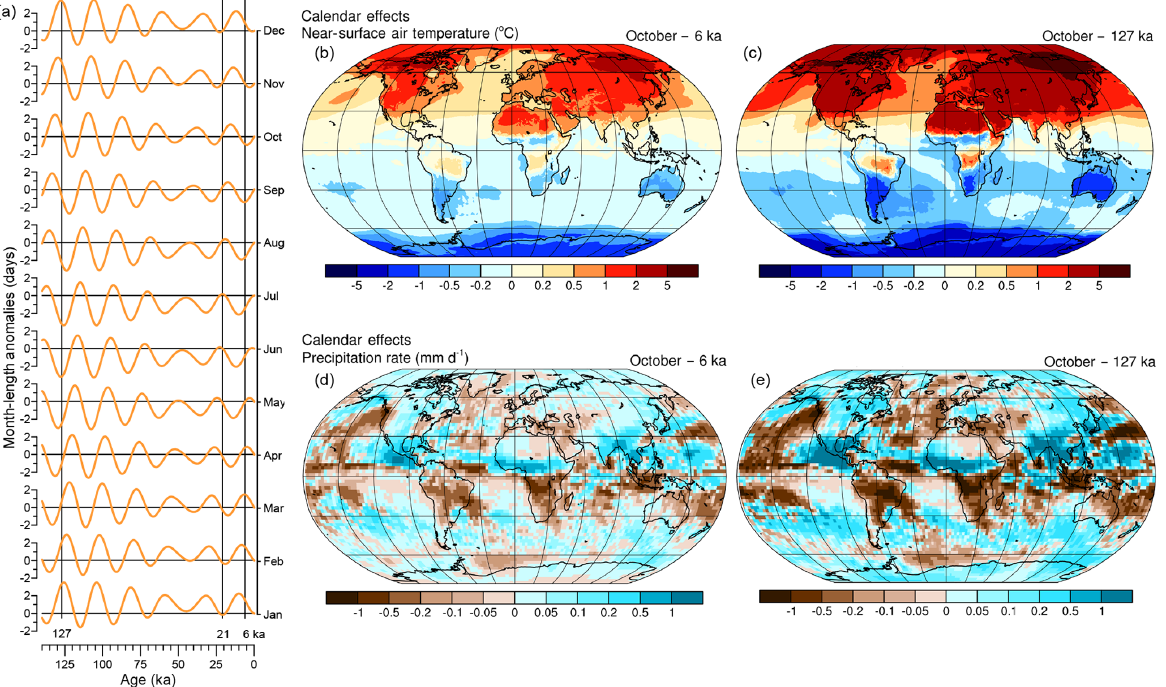
Figure A1. The calendar effect: (a) month-length anomalies, 140ka to present, with the PMIP4 experiment times indicated by vertical lines. The month-length anomalies were calculated using the formulation in Kutzbach and Gallimore (1988). (b, c) The calendar effect on October temperature at 6 and 127ka, calculated using Climate Forecast System Reanalysis near-surface air temperature (https://www.earthsystemcog. org/projects/obs4mips/), 1981–2010 long-term means, and assuming the long-term mean differences in temperature are zero everywhere. (e, f) The calendar effect on October precipitation at 6 and 127ka, calculated using the CPC Merged Analysis of Precipitation (CMAP) enhanced precipitation (http://www.esrl.noaa.gov/psd/data/gridded/data.cmap.html), 1981–2010 long-term means, and again assuming that the long-term mean differences in precipitation are zero everywhere. Calendar effects were calculated by interpolating present-day monthly temperature or precipitation to a daily time step as in Pollard and Reusch (2002, but using a mean-preserving algorithm for pseudo-daily interpolation for monthly values; Epstein, 1991), and then recalculating the monthly means using the appropriate palaeo-calendar (Bartlein and Shafer, 2016). Note that the 6 and 127ka map patterns for both variables, while broadly similar, are not simply rescaled versions of one